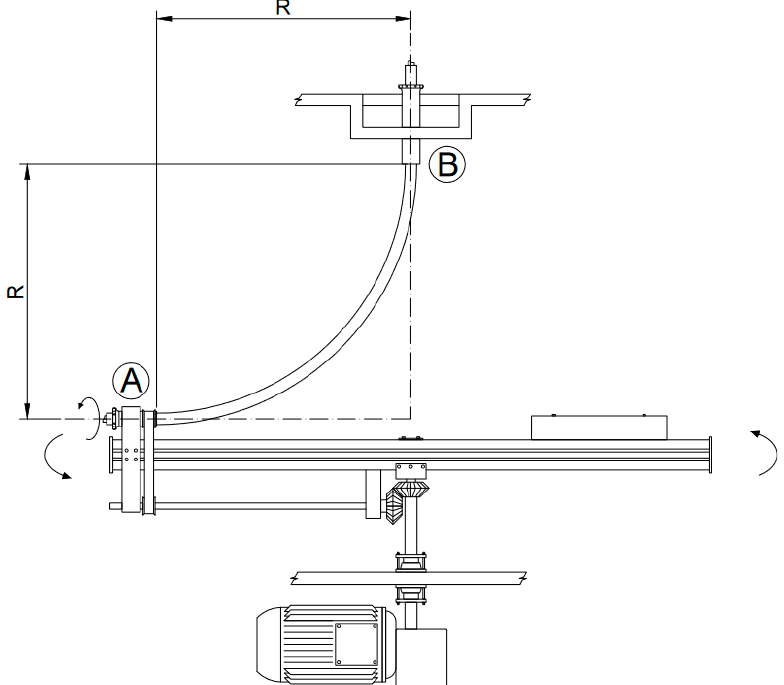
Figure 3. The test rig setup with cable mounted. The cable is fixed at the top, and the rotating end is controlled via a mechanical drive visible at the bottom of the picture (A and B are end points, see the text for clarification).